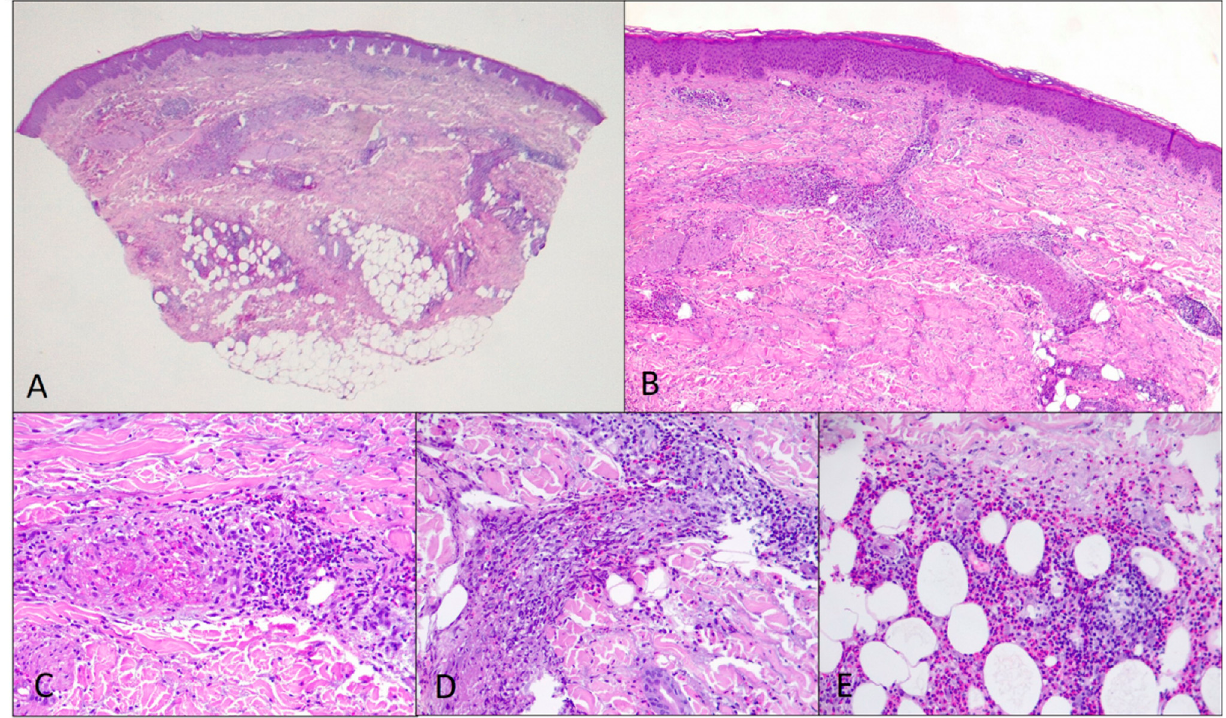
Figure 4. ( A ) Skin punch biopsy with unremarkable epidermis and underlying dermis showing prominent superficial and deep perivascular inflammation also involving subcutaneous adipose tissue (HE ×12.5); ( B ) venules of the superficial vascular plexus showing fibrinoid necrosis associated with numerous eosinophils, lymphocytes, and associated karyorrhectic debris (HE ×50); ( C ) and ( D ) close-up view of the vasculitis process (HE ×200); ( E ) close-up view of the heavy infiltrate of eosinophils in the subcutaneous adipose tissue (HE ×200).